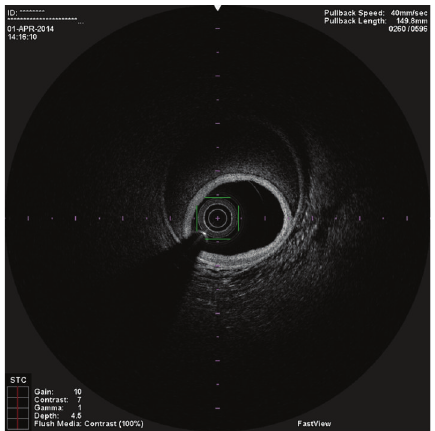
Figure 4: OCT image showing the entry tear of the spontaneous dissection.